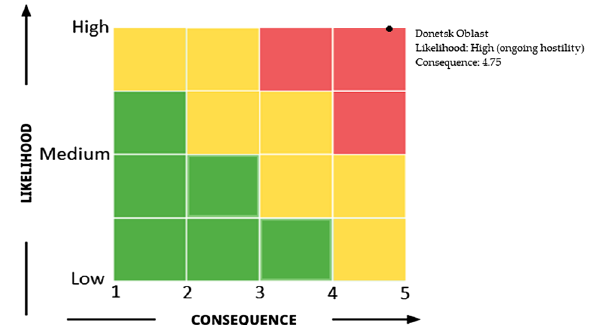
Figure 11. Disaster risk matrix for Donetsk Oblast.